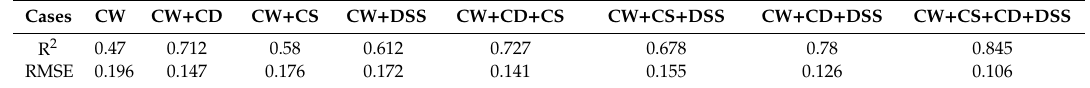
Table 4. Results of cases with stirrups and variables without including corrosion level ( n =